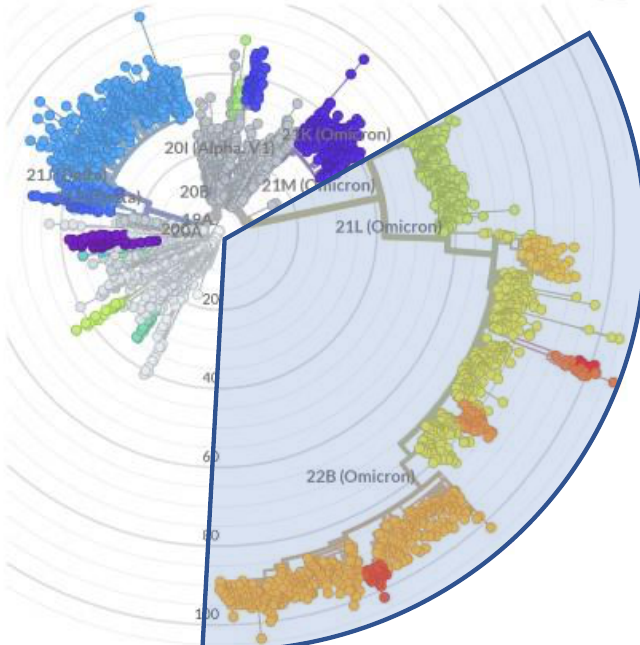
Figure 1. Radial tree of SARS-CoV-2 evolution, with branch length approximating divergence, showing that Omicron (light blue shadow) currently includes more than 45% or variations across 3193 genomes sampled between December 2019 and December 2022. Accessed online at https://nextstrain.org/ncov/gisaid/global/all-time?l=radial&m=div (accessed on 26 December 2022).